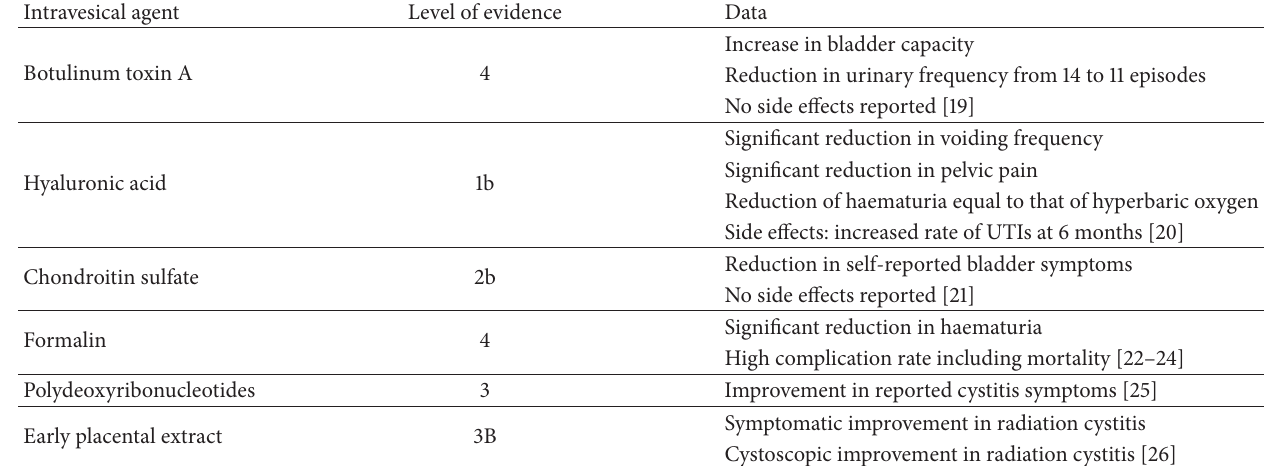
Table 4: The proposed intravesical treatments for radiation cystitis and their levels of evidence.